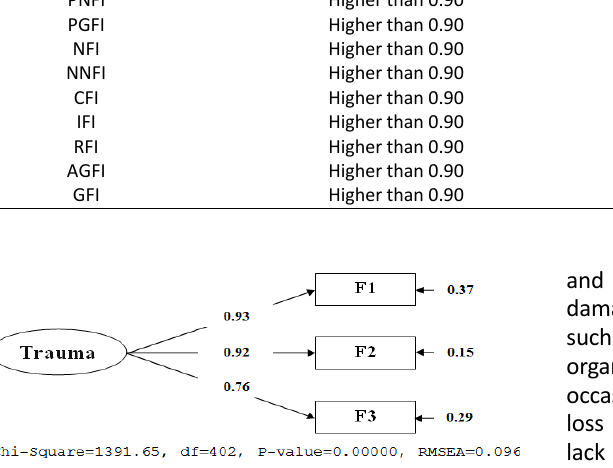
Fig. 1: Organizational trauma model in standard mode